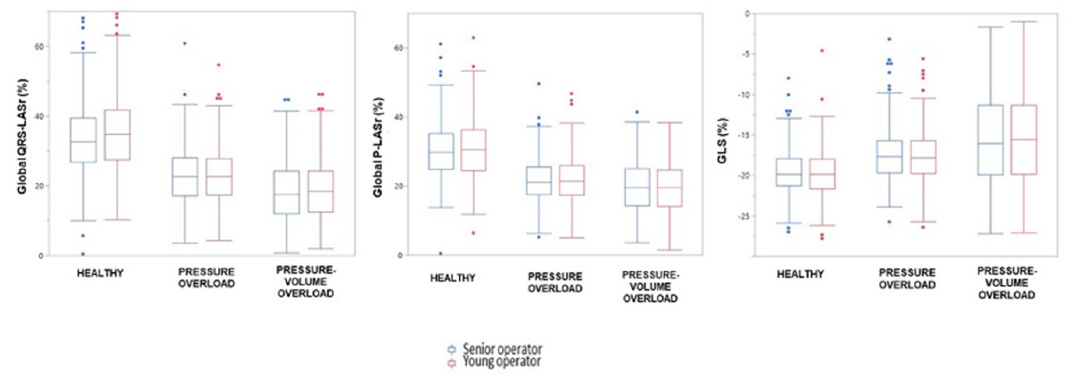
Figure 2. Global QRS-LASr, global P-LASr and GLS in the different study groups. Comparison of strain parameters measurements between senior (blue) and young (red) operators. From the left: global QRS-LASr, global P-LASr and left ventricular GLS. LASr = left atrial strain during reservoir phase; GLS = global longitudinal strain.